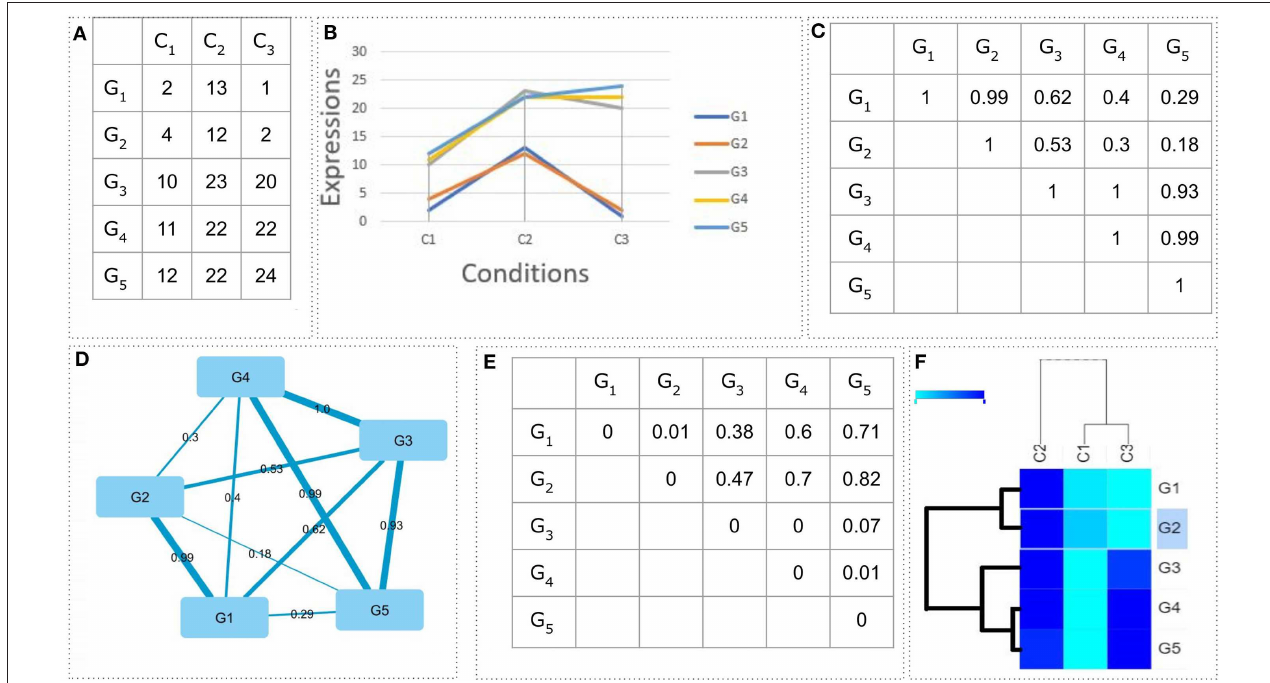
FIGURE 11 | Example of hierarchical clustering. (A) The expression values of five genes in three conditions. (B) The chart showing the genes’ expression values as patterns. (C) The Pearson correlation coefficient (PCC) matrix showing all pairwise PCC values. (D) The Pearson correlation matrix in the form of a fully connected graph. (E) The distance matrix as a product of the PCC matrix ( D ij = 1 − PCC ij ). (F) A 2D average linkage hierarchical clustering. Genes G1, G2 as well as genes G3, G4, G5 are clustered together.